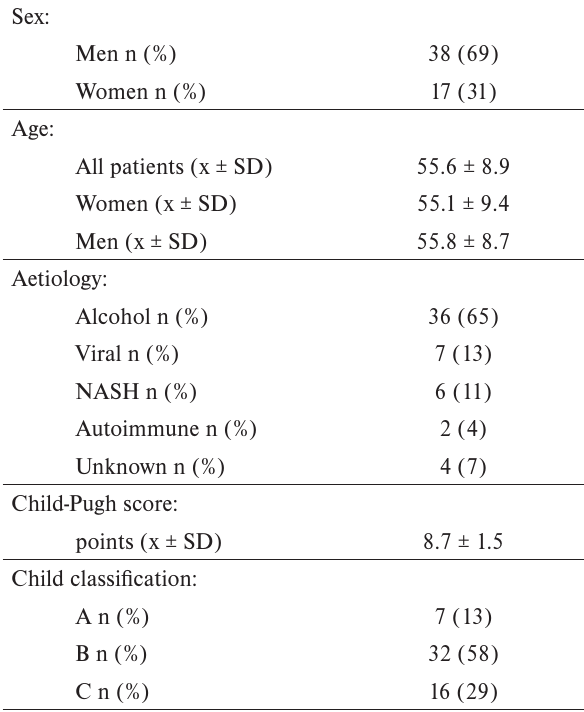
Table 1. Shows patient demographic characteristics. Table 2. Shows haemodynamic and echocardiographic